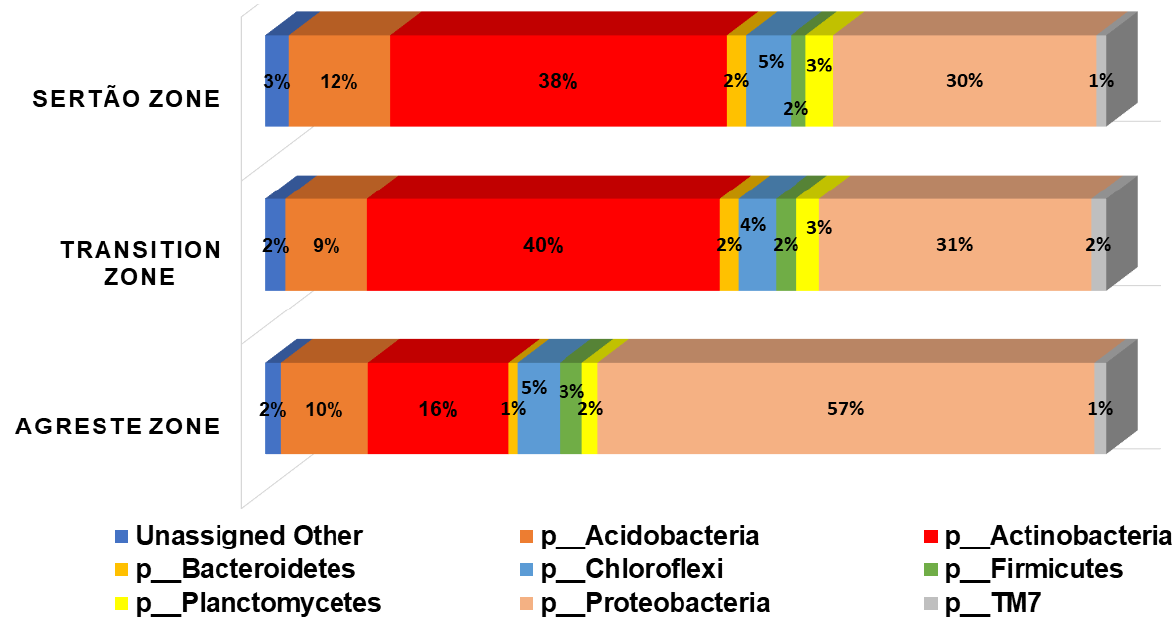
Figure 3. Relative abundance of the major taxonomic groups observed in the mesoregions of the State of